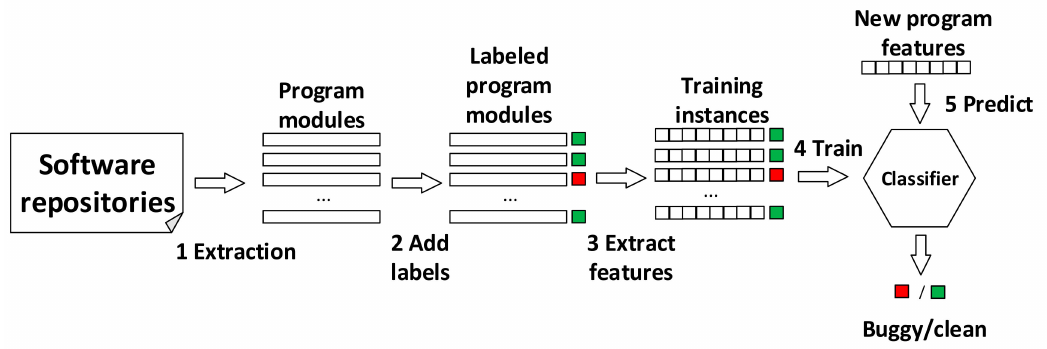
Figure 1. A typical software defect prediction process based on machine learning.